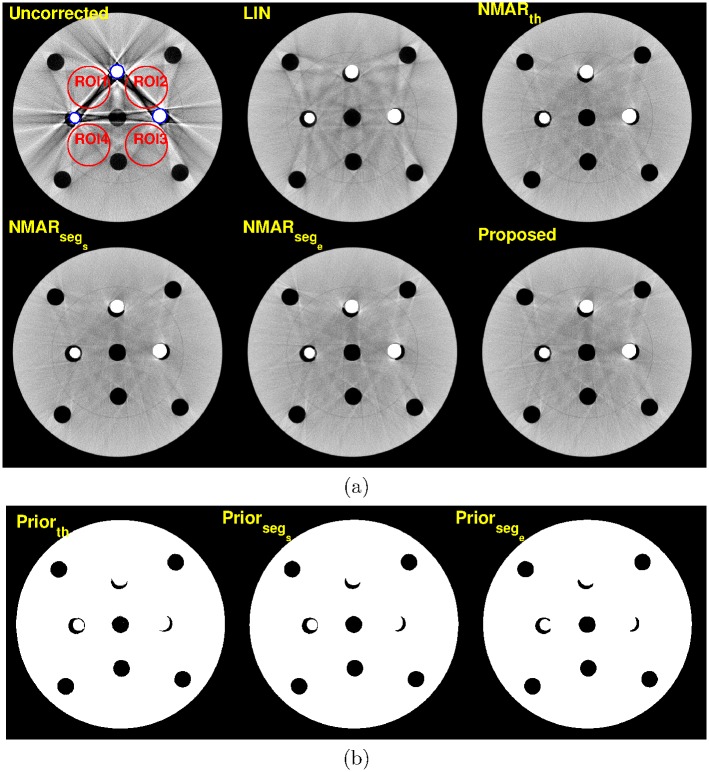
Results of a PMMA phantom (C = 0 HU/W = 600 HU).(a) Top row: reconstruction images by (left) Uncorrected, (middle) LIN, and (right) NMARth images. Bottom row: reconstruction images by (left) NMARsegs, (middle) NMARsege, and (right) the proposed results. ROI 1- ROI 4 are indicated by red lines on the uncorrected image. (b) Prior images. Left: prior by simple thresholding, middle: prior by RAC segmentation of the LIN image, right: prior by RAC segmentation of the final iteration image.